Question: Which kind of chart has been used to present this data?
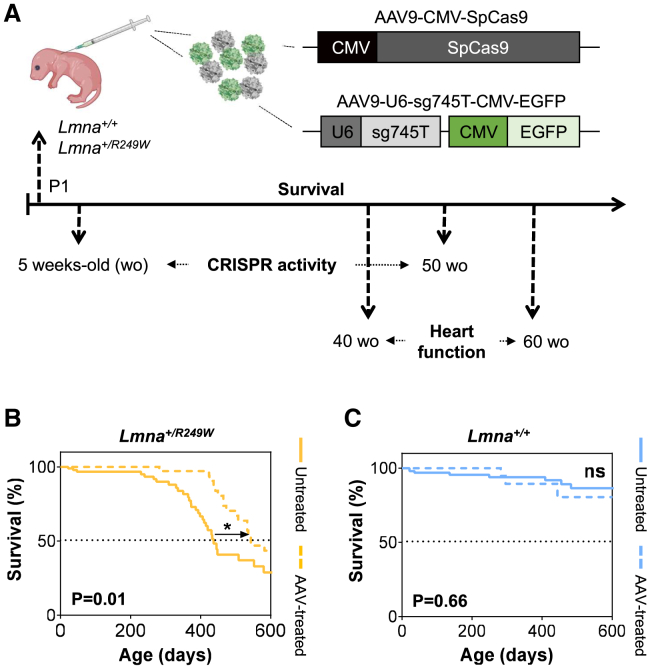
Answer: survival